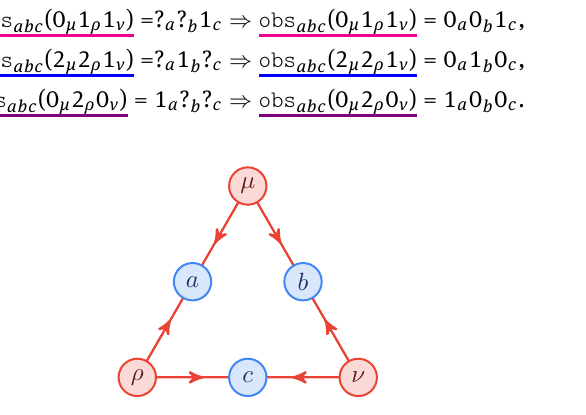
Figure 11: The Triangle structure G 11 involving three visible variables V = { a , b , c } each sharing a pair of latent variables from L = { µ , ν , ρ }